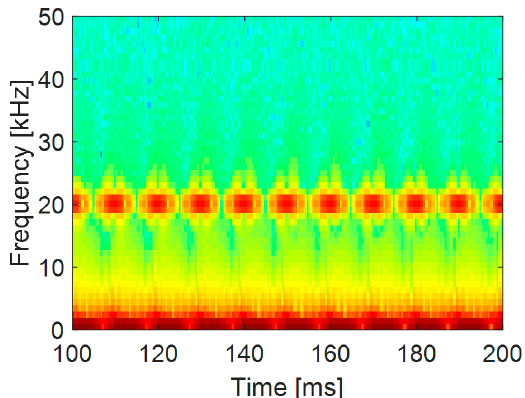
Figure 5. Case study 1: Time-frequency representation obtained by means the spectrogram with 1 kHz frequency resolution and 1 ms time resolution.